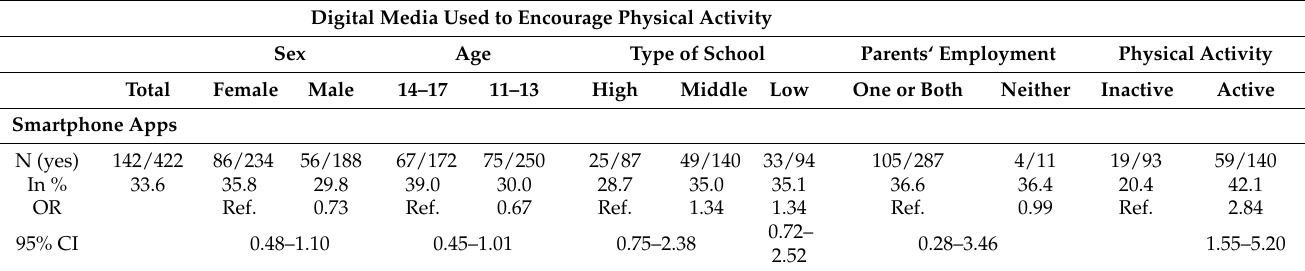
Table 4. Indicators and statistics for digital media used to encourage physical activity by sociodemographic